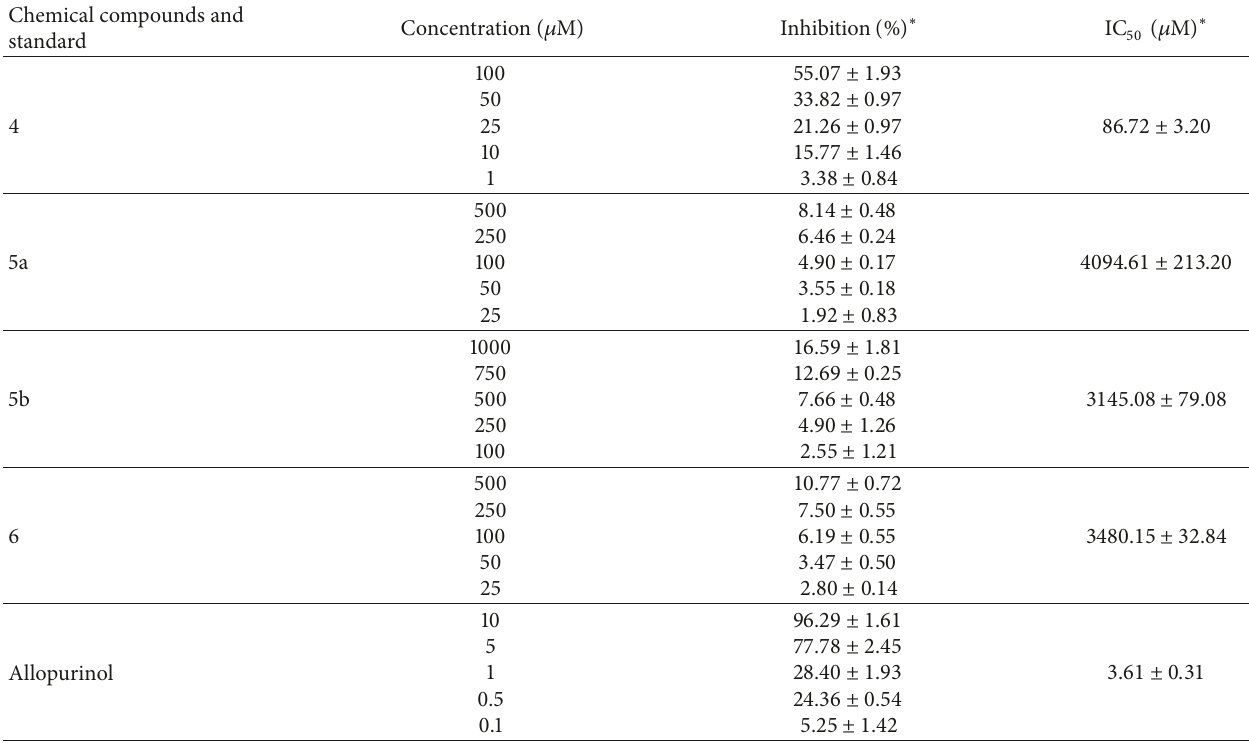
Table 1: The xanthine oxidase inhibitory activity of different concentrations of S-substituted perhalonitrobuta-1,3-diene compounds. Chemical compounds and